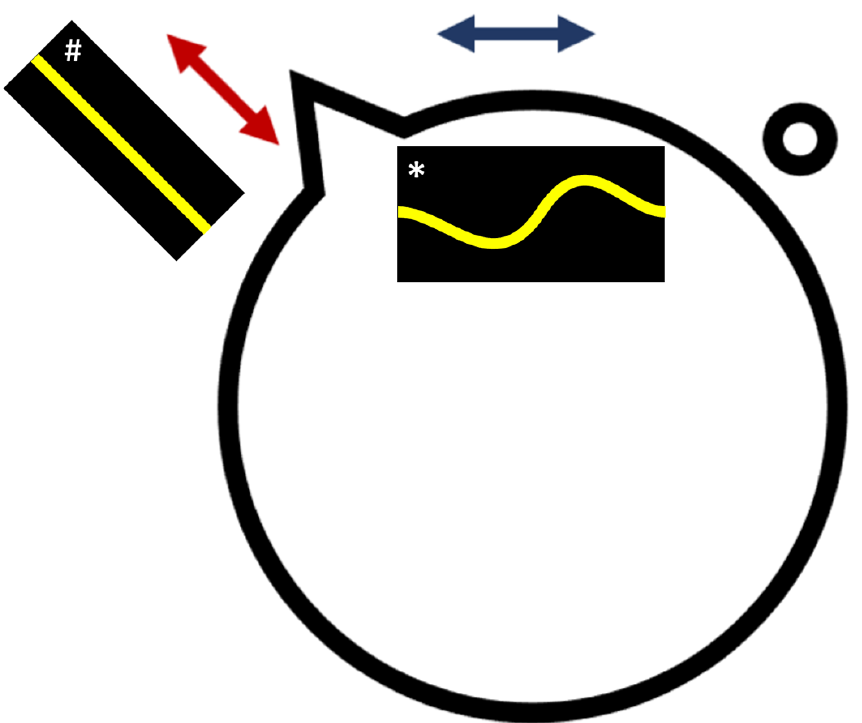
Figure 4. Hypothetical explanation for the association between retinal irregularity and retinal detachment. This schematic illustrates the posterior margin of the vitreous base (identified by the thick black line). Mid-peripheral retinal Bruch’s membrane grows in every direction during eye enlargement with myopisation. The limited growth of the eye in the coronal plane restricts Bruch’s membrane expansion, compressing it and leading to increased irregularity seen with retinal OCT (blue arrow and cartoon OCT with asterisk *). The greater growth of the eye in the antero-posterior direction leaves the retinal contour flattened or less irregular (cartoon OCT with hash mark #). The risk of retinal detachment arises from uneven antero-posterior Bruch’s membrane expansion drawing the posterior margin of the vitreous base posteriorly (red arrow), producing triangular protrusions or circular islets. These points are subject to increased mechanical stress during PVD, leading to retinal break or hole formation. The classifier identifies retinal detachment eyes by the coronal compression of Bruch’s